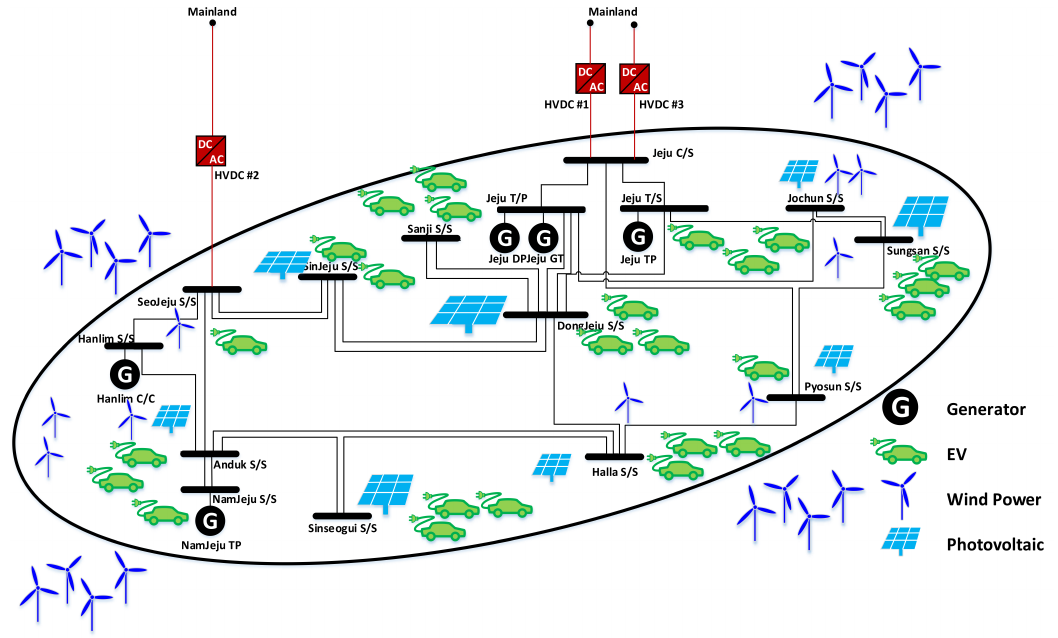
Figure 2. Jeju Island power system diagram. HVDC: high-voltage direct